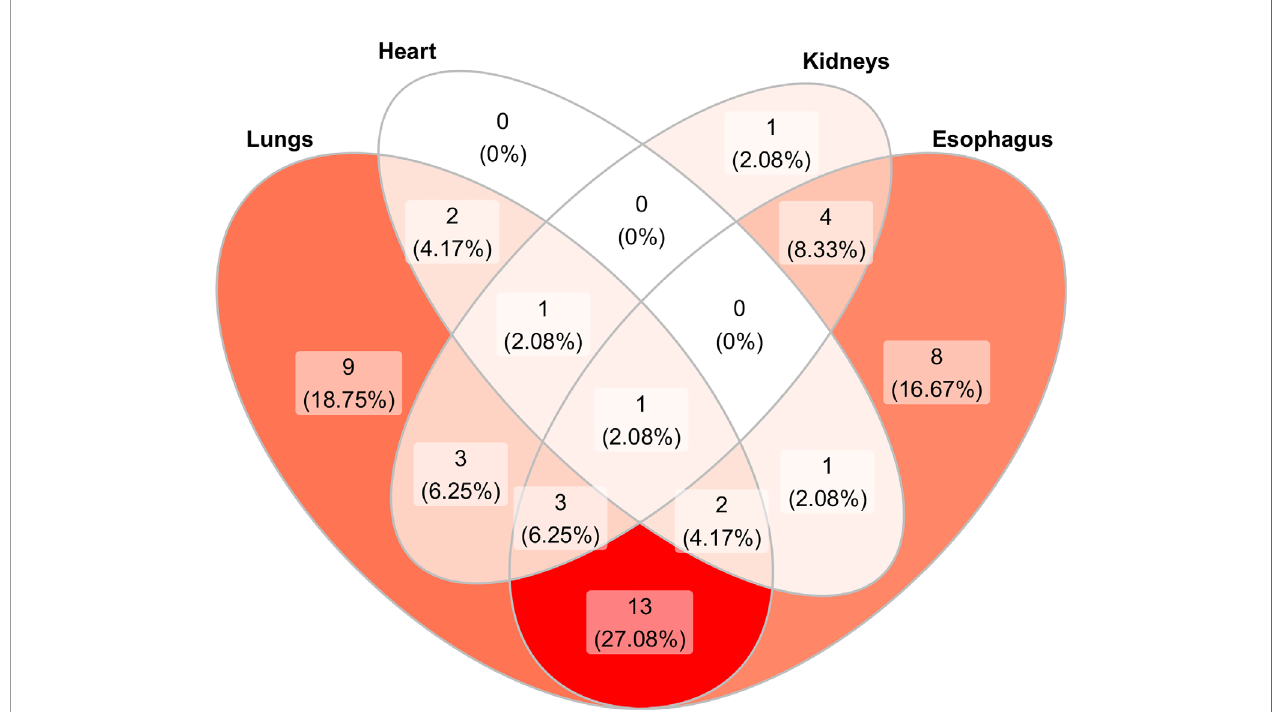
FIGURE 2 | Venn diagram showing the distribution and overlap of organ involvement in the 52 scleroderma patients studied. In dark red color is represented the most common association. The color fades progressively as the association decreases. The majority of patients (27.08%) presented both esophageal and pulmonary involvement while only 1 patient presented all organ involvement. No patient showed only cardiac involvement or kidney – heart or kidney – esophagus